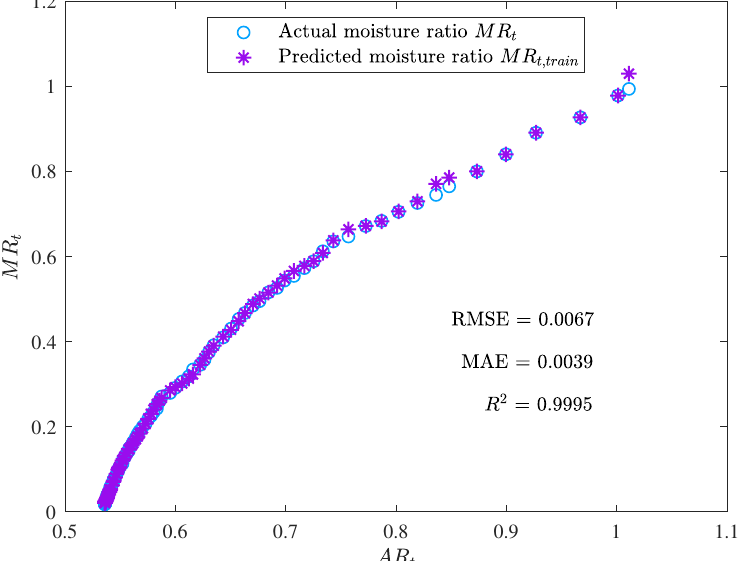
Figure 5. The training result of the ANN model (the moisture ratio given by the trained model MR t , train vs. the area ratio AR t